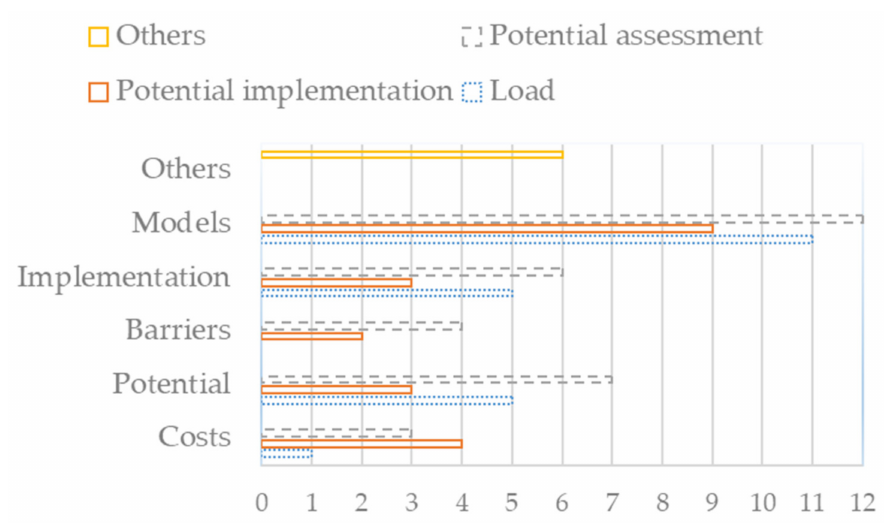
Figure 6. Distribution of the selected literature on demand